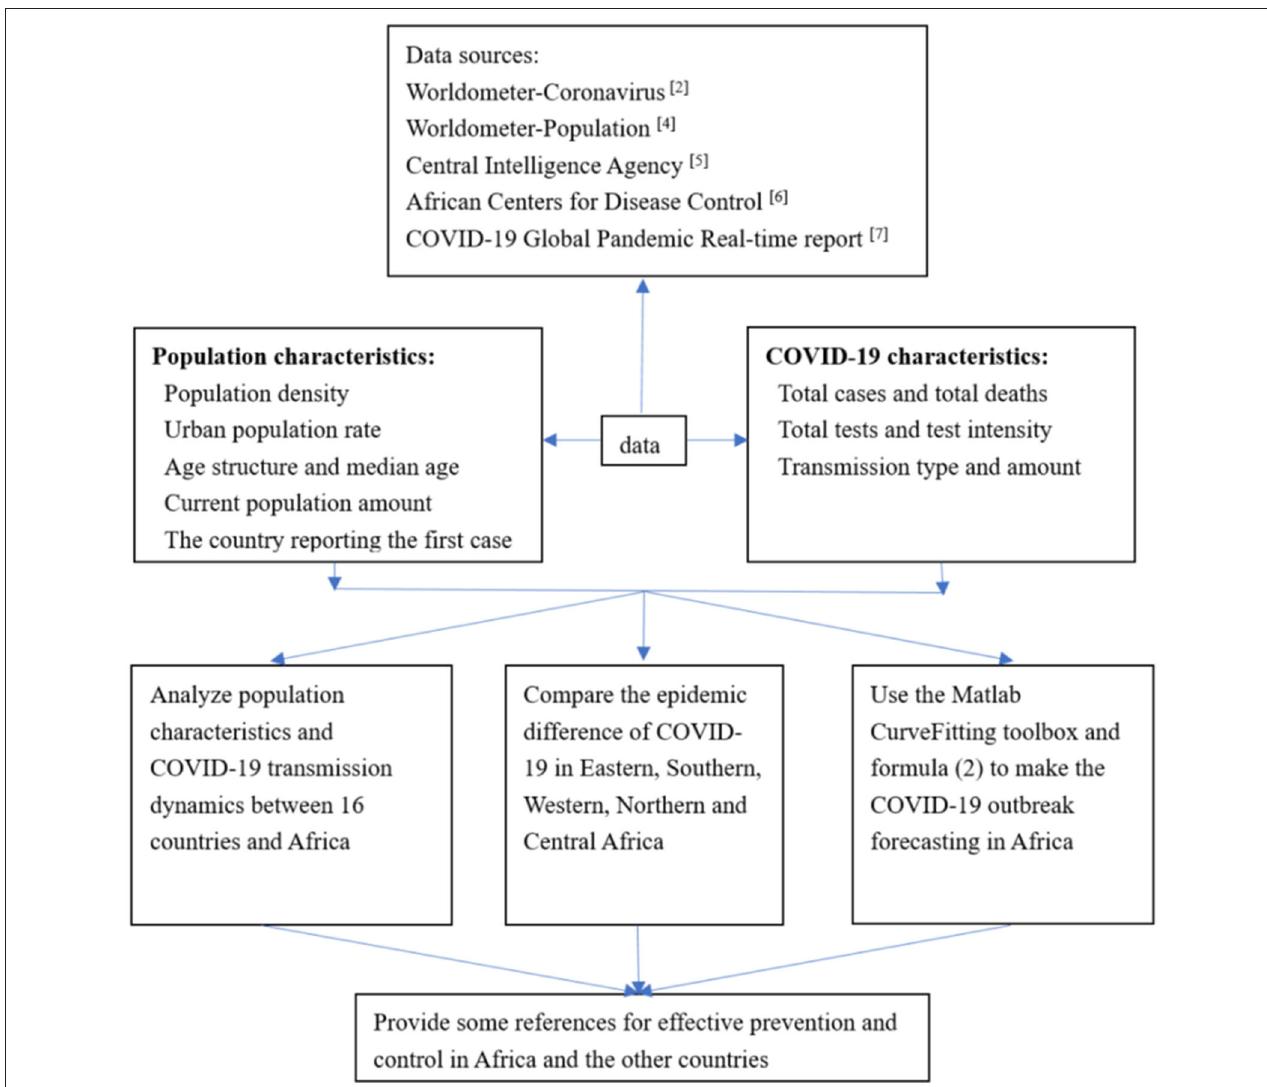
FIGURE 1 | Flowchart of this article.